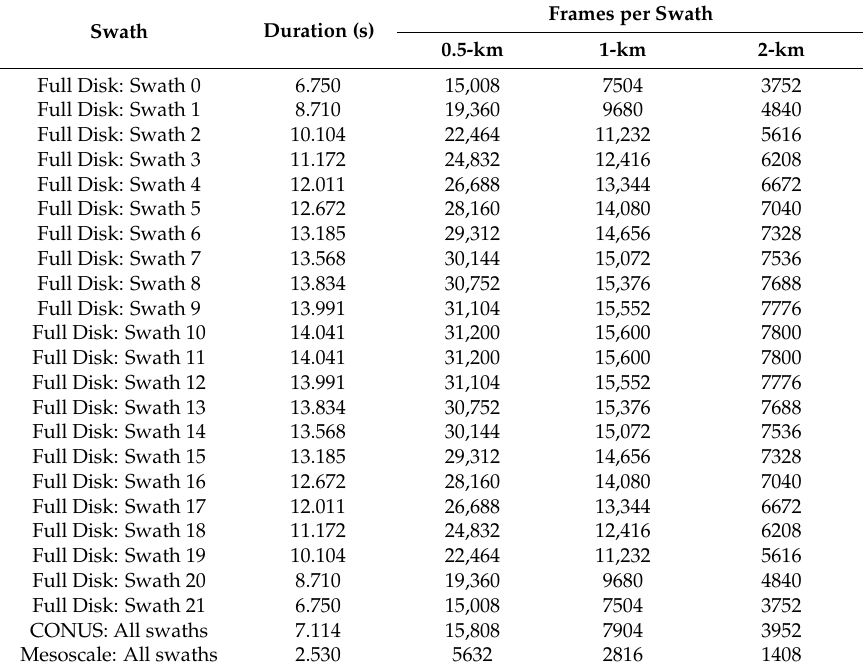
Table 2. The number of frames per swath and the swath duration.